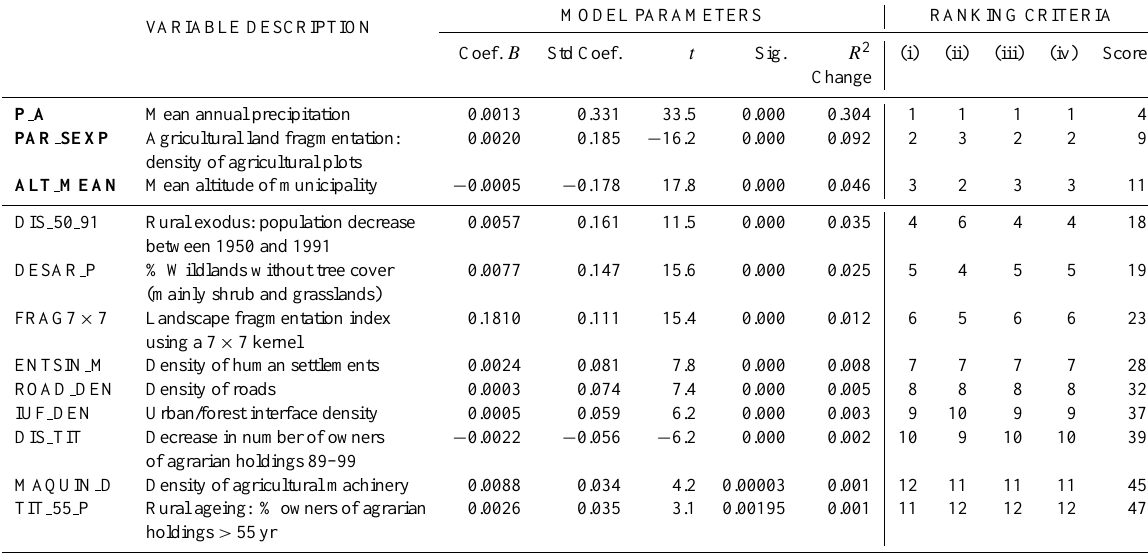
Fig. 3. Residual analysis of the OLS regression model: scatterplots between observed and predicted observations (A) , histogram data plots of the standardized residuals (B) , normal Q − Q plot of the standardized residuals (C) and map of the standardized residuals (D) . Table 3. Model parameters and sensitivity analysis for ordinary linear regression model (OLS): ranking of influence of the input variables (the lower the ranks, the more